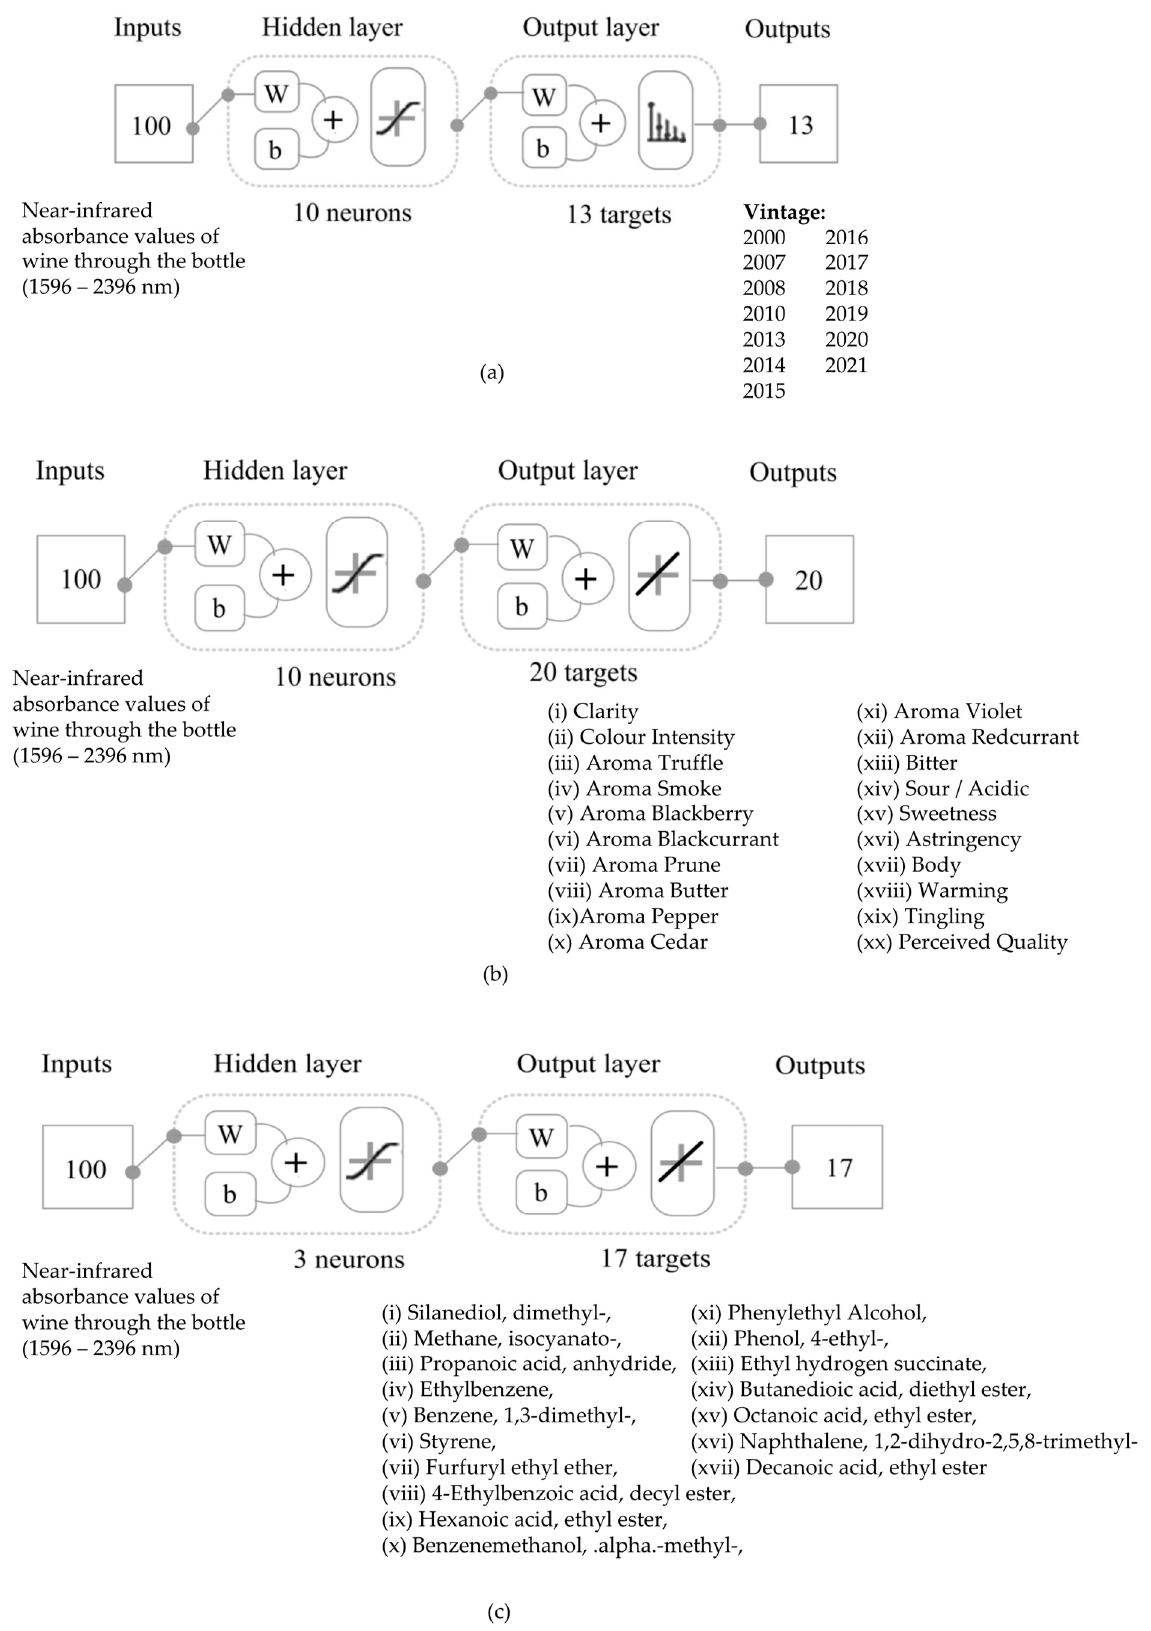
Figure 2. Machine learning diagrams showing the inputs, targets, and number of neurons used for ( a ) classification Model 1, ( b ) regression Model 2, and ( c ) regression Model 3. Abbreviations: W—weights;